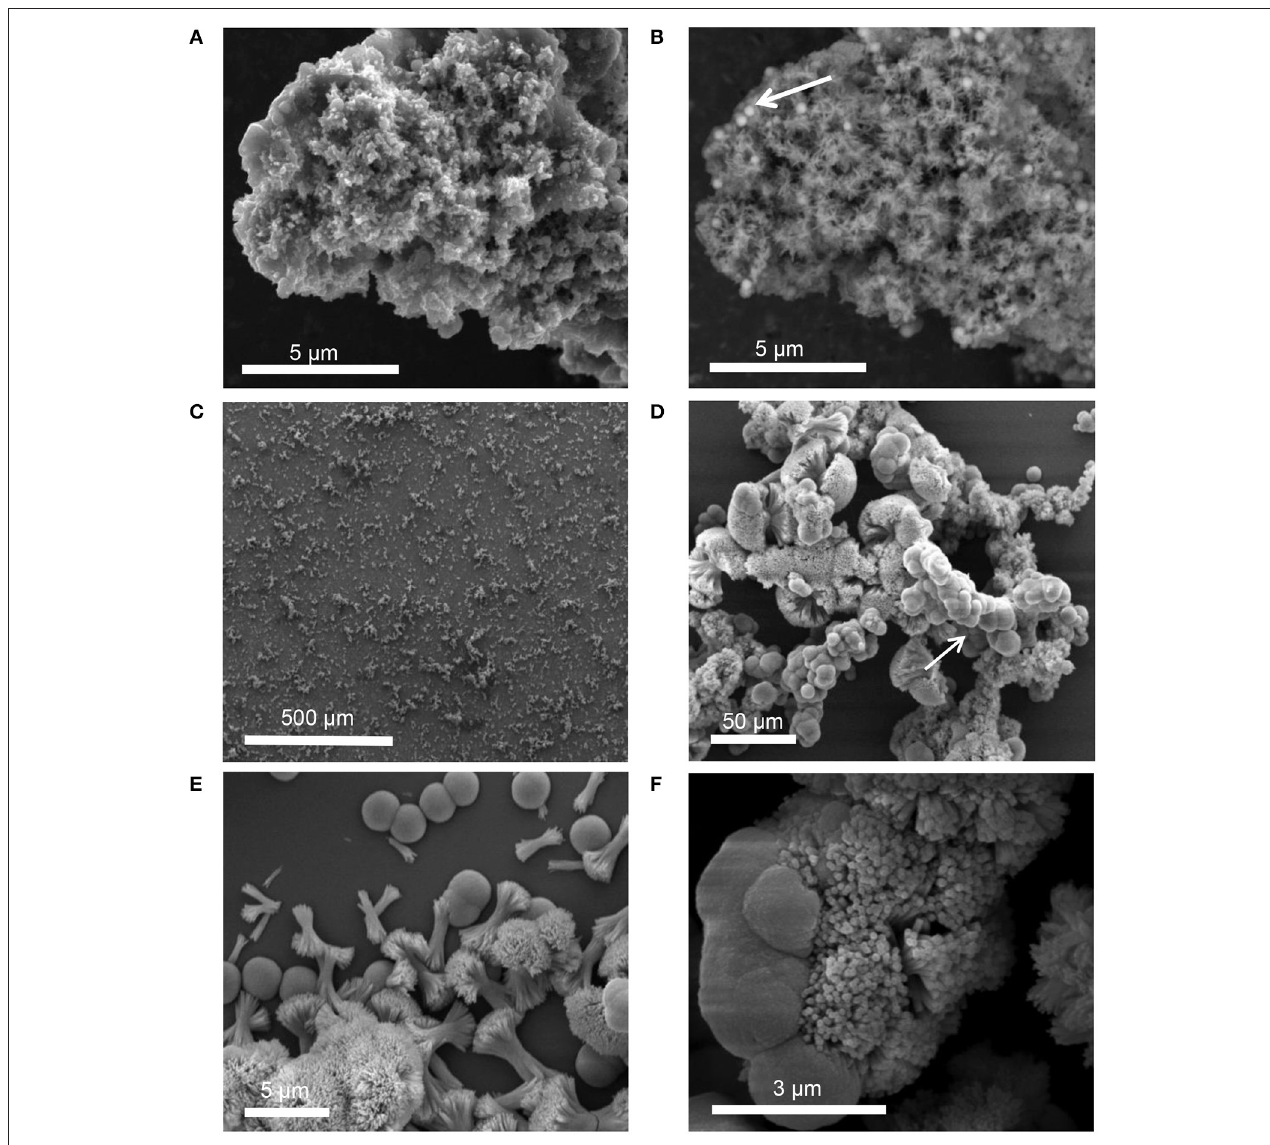
FIGURE 6 | SEM images of precipitate formed in solution containing STNA15-ELP at 3 h [ (A) SE and (B) BSE] and 8 days (SE: C – F ) of